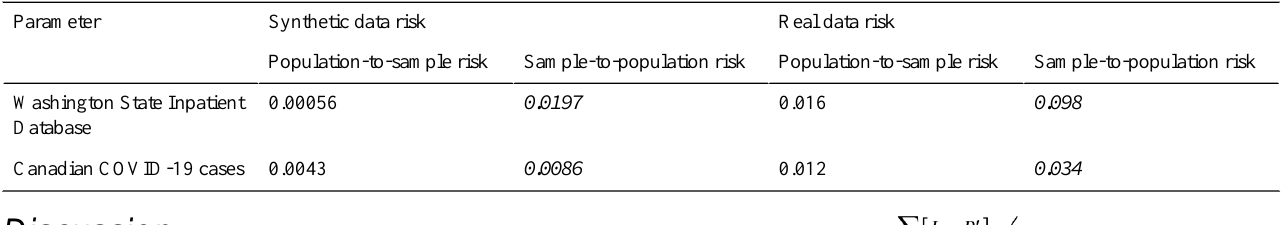
Table 6. Overall meaningful identity disclosure risk results. (The italicized values are the maximum risk values.)